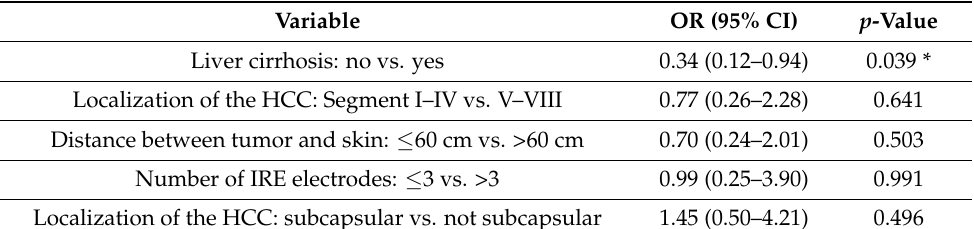
Table 2. Results of a binary logistic regression model predicting the local tumor progression of a hepatocellular carcinoma after irreversible electroporation.